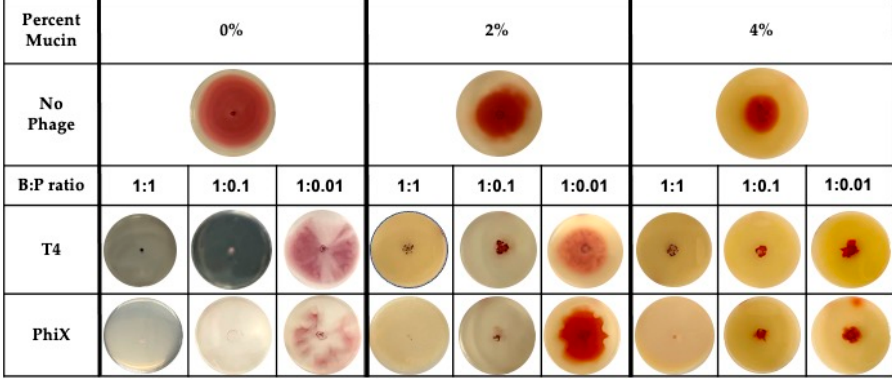
Figure 1. Even distribution of phages within mucin-containing motility plates allows for hinderance of bacterial motility at low MOI . Bacterial motility, as indicated by distance of bacterial metabolism (red color) from original inoculation site (center of plate) within plates containing no (0%), 2%, or 4% mucin. Plates contained no phages ( top row ), bacteria:phage (B:P) ratio of 1:1 (left columns for each percentage), 1:0.1 (center columns for each percentage), or 1:0.01 (right columns for each per- centage) of either T4 ( middle row ) or PhiX ( bottom row ). Images are representative of all results ( n ≥